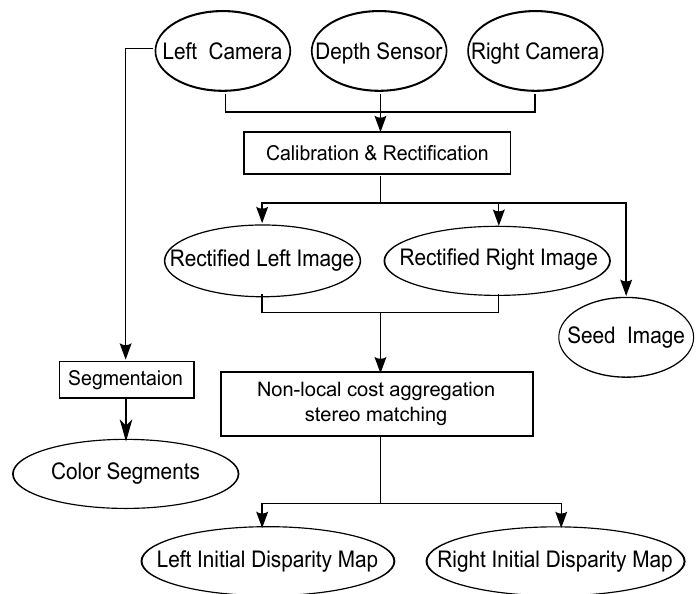
Figure 3. Conceptual flow diagram for the calibration and rectification